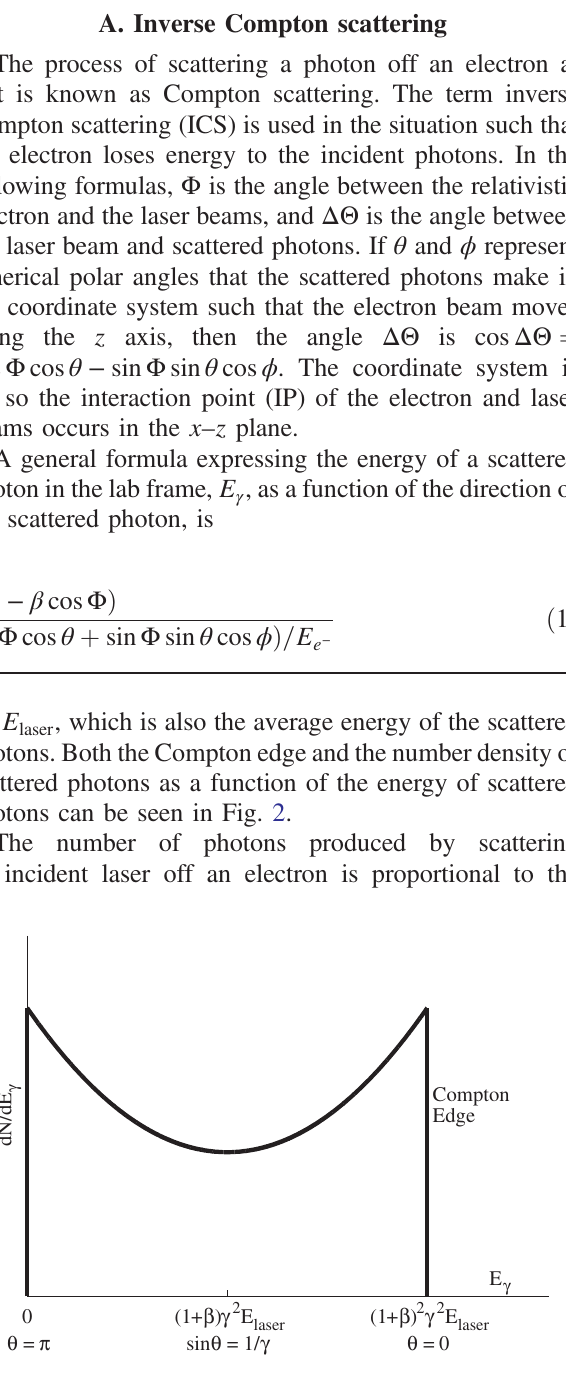
FIG. 2. Number density of scattered photons as a function of the energy of scattered photons. Annotated Fig. 2 from